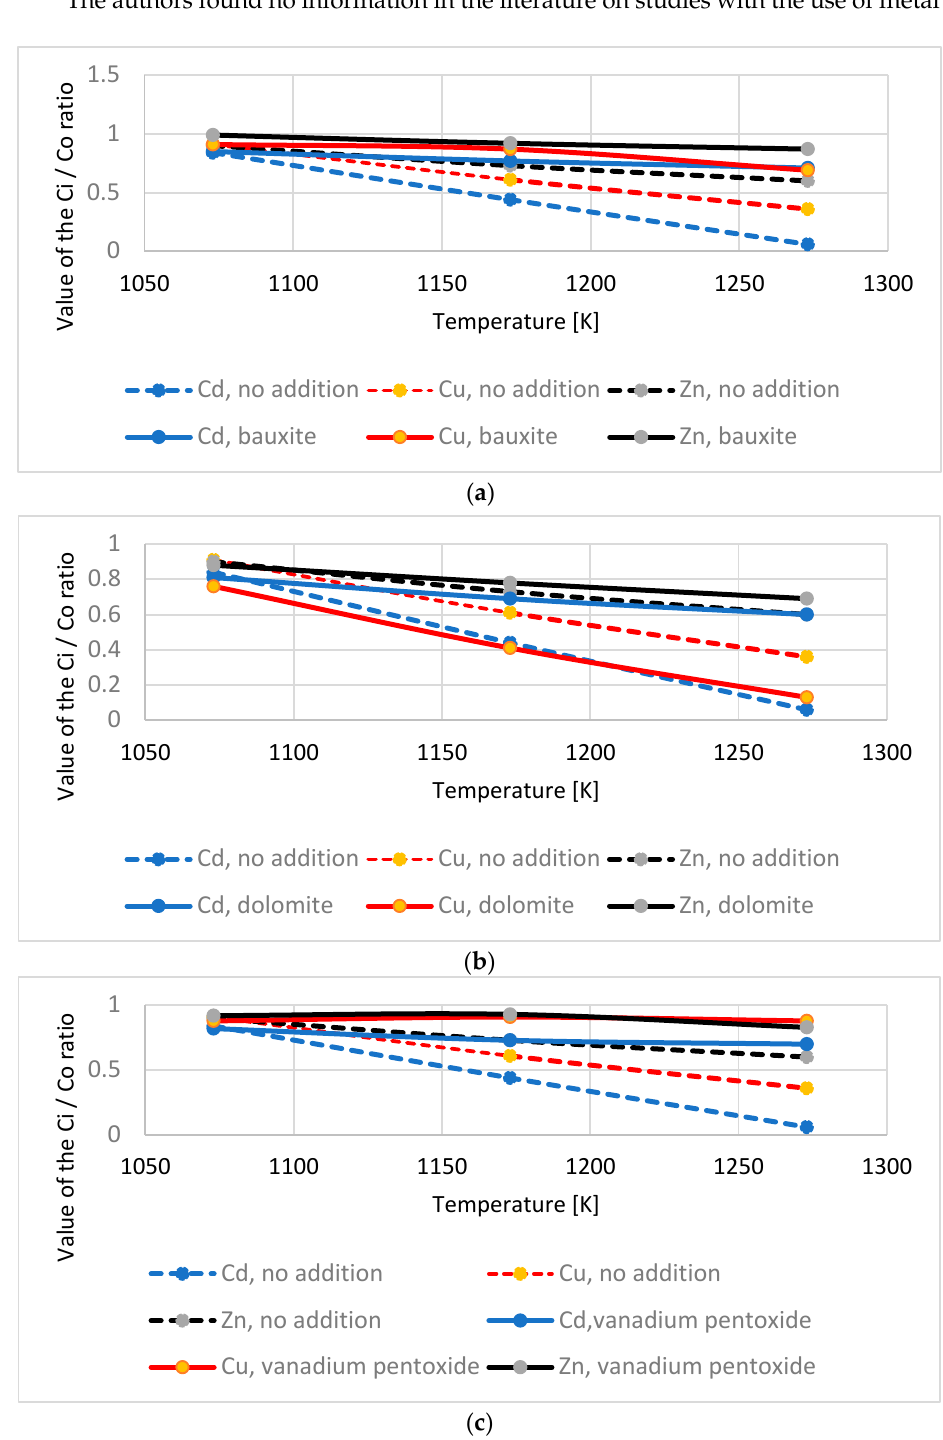
Figure 2. Dependence of the Ci/Co value on the roasting temperature in the samples of nitrates (V); ( a ) with the addition of bauxite, ( b ) with the addition of dolomite, ( c ) with the addition of V 2 0 5.